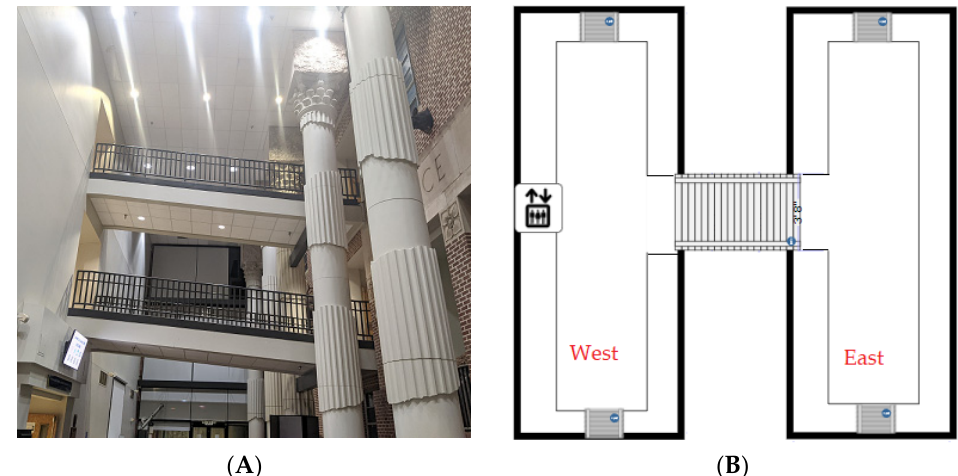
Figure 5. Experimental setting. ( A ) A side view of the overall building, ( B ) A bird’s eye view.